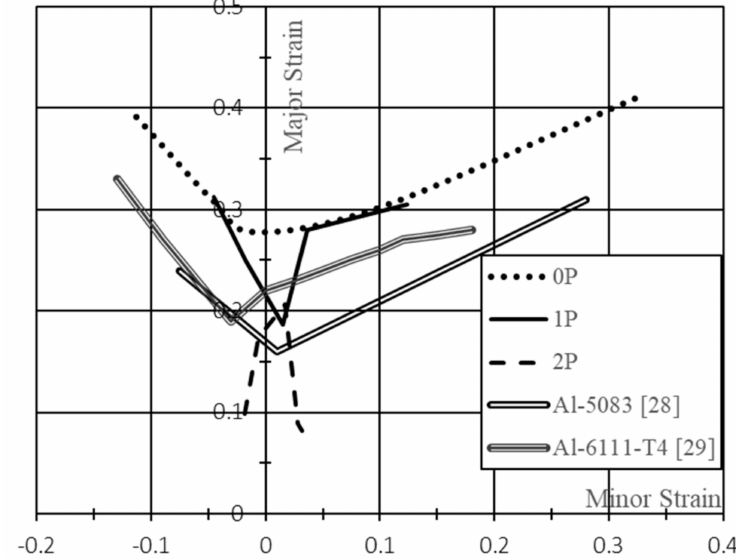
Figure 6. Forming limit curves of the material before and after being processed by RCS, and comparison curves from the literature